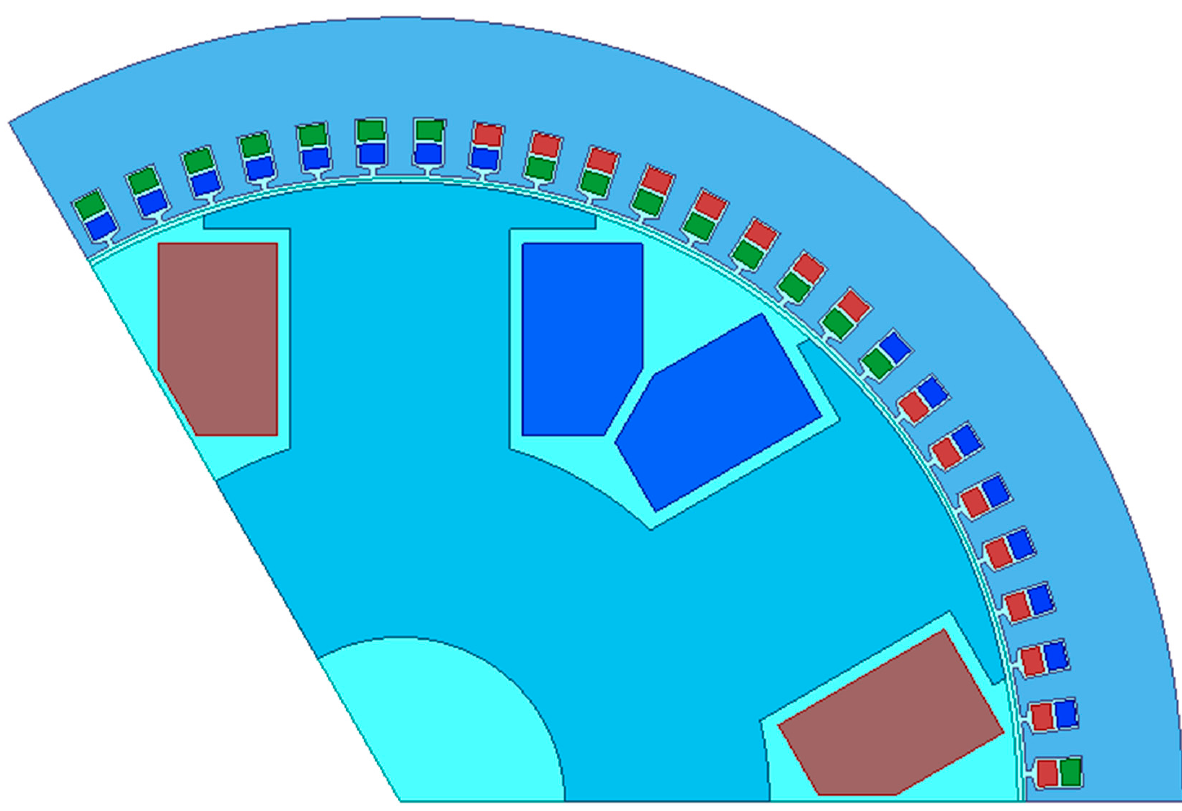
Figure 3. The 1/3 model of the main motor.